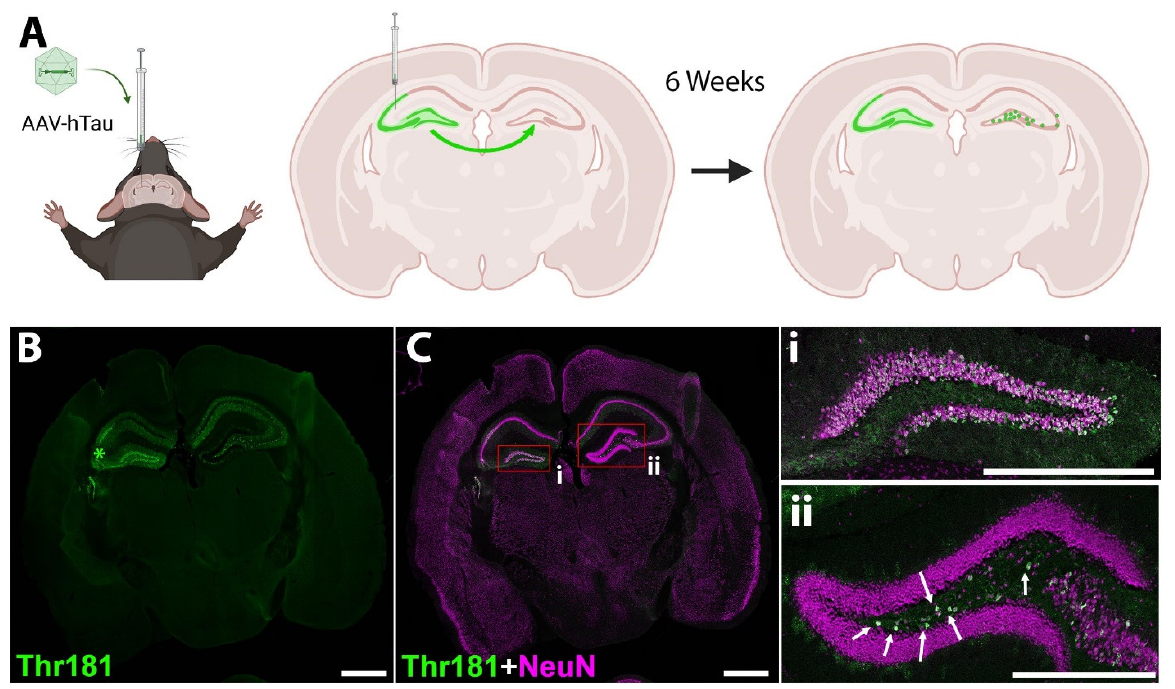
Figure 5. Murine model of mutant hTau propagation. ( A ) Schematic of the model. AAV vector expressing human P301L/S320F double mutant tau is injected into the left dorsal hippocampus near the CA3 region. The vector is taken up by hippocampal neurons, and after 6 weeks, phosphorylated tau expression is observed both in neurons of injection site (including hilus region of dentate gyrus) and neurons of the contralateral hilus region of the dentate gyrus (DG). Image was created with BioRender.com. ( B ) Representative image of Thr181 phosphorylated tau 6 weeks following AAV-hTau injection. Staining is observed in the left dorsal hippocampus near the CA3 region where injected (*). After six weeks, Thr181 phosphorylated tau staining is also observed in neurons of the contralateral hilus region of the dentate gyrus. ( C ) Merged image showing Thr181 tau (green) and neuronal NeuN (magenta) staining. Scale bar 1000 µm. ( i ) Inset from ( C ) showing the ipsilateral DG; ( ii ) inset from ( C ) showing the contralateral DG. Arrows indicate neurons that have taken up tau in the hilus region. Scale bar, 500 µm.